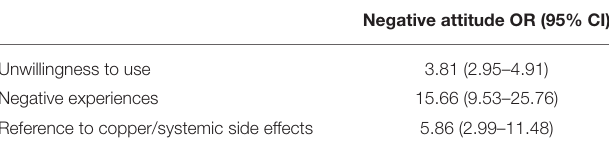
TABLE 3 | Associations between negative attitudes toward and negative experience of, unwillingness to use, and having made reference to copper-related or systemic side effect of the copper IUD, expressed as odds ratios (ORs) with 95% confidence intervals